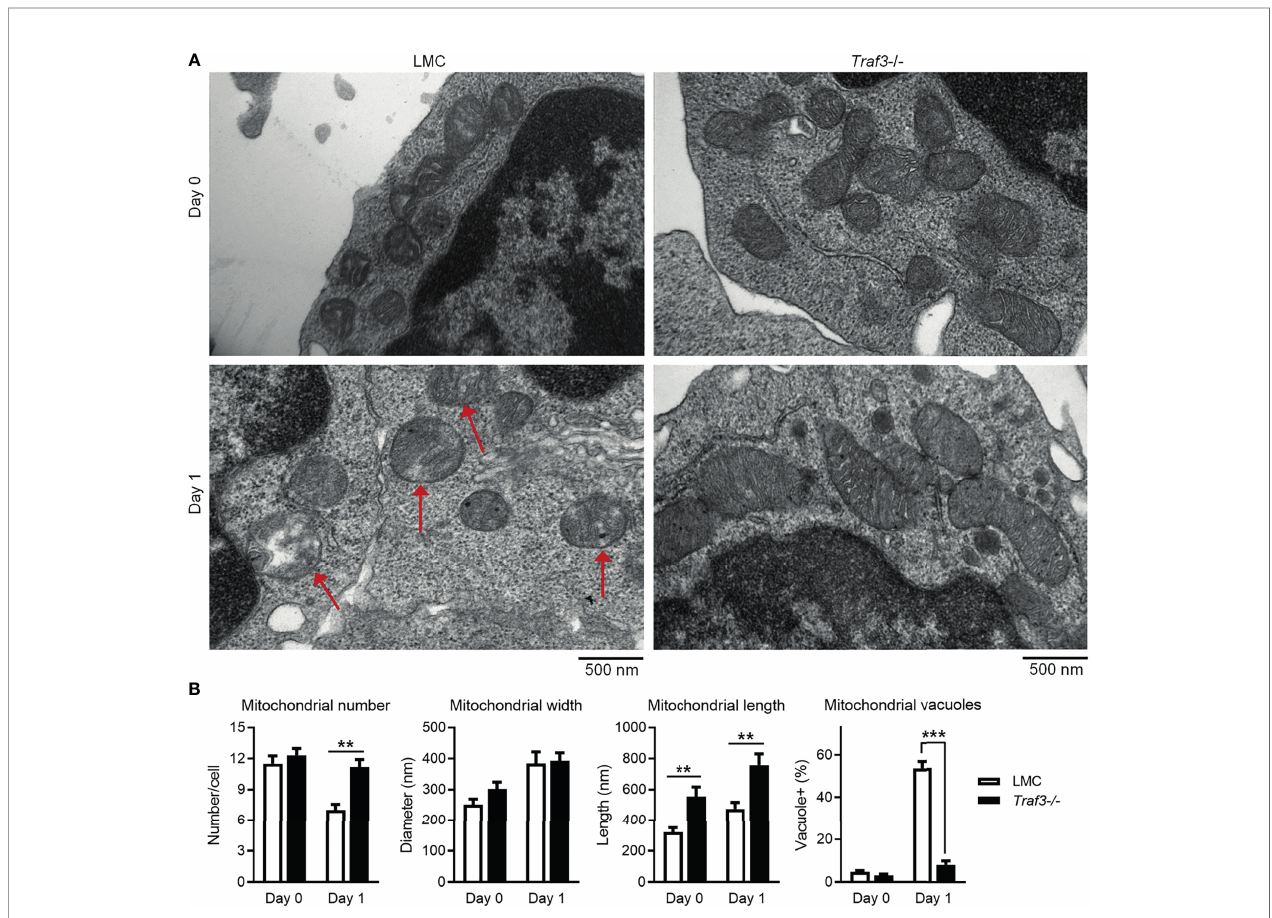
FIGURE 4 | TRAF3 regulated the number and morphology of mitochondria in resting B cells. Splenic B cells were puri fi ed from gender-matched, young adult (8-12- week-old) naïve LMC or B- Traf3 -/- mice. Puri fi ed cells were analyzed directly (Day 0) or at day 1 after ex vivo culture. The number and morphology of mitochondria in cells were analyzed by electron microscopic (EM) examination. (A) Representative EM micrographs of resting B cells. Sick mitochondria are indicated with red arrows in the fi gure. (B) Graphical results of the number, width and length of mitochondria as well as the percentage of cells containing sick mitochondria (vacuole+) determined by EM examination. Graphs shown are the mean ± SD (n = 6/group; ** p < 0.01; *** p < 0.001 by t